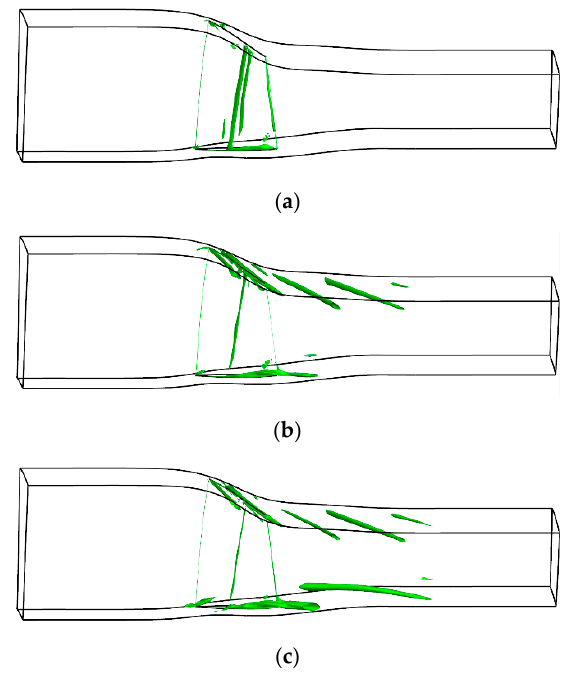
Figure 15. Iso − surface of the Liutex components at the NC condition. ( a ) Liutex component in the x − axis. ( b ) Liutex component in the y − axis. ( c ) Liutex component in the z − axis.